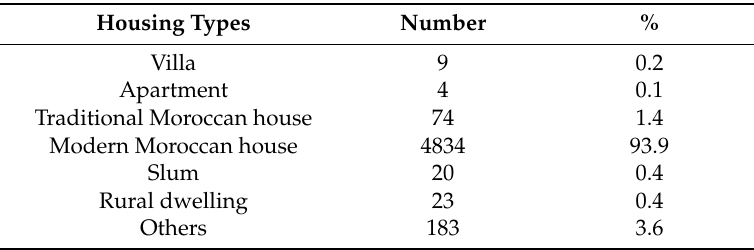
Table 1. Types of housing in the city of Imzouren [20].